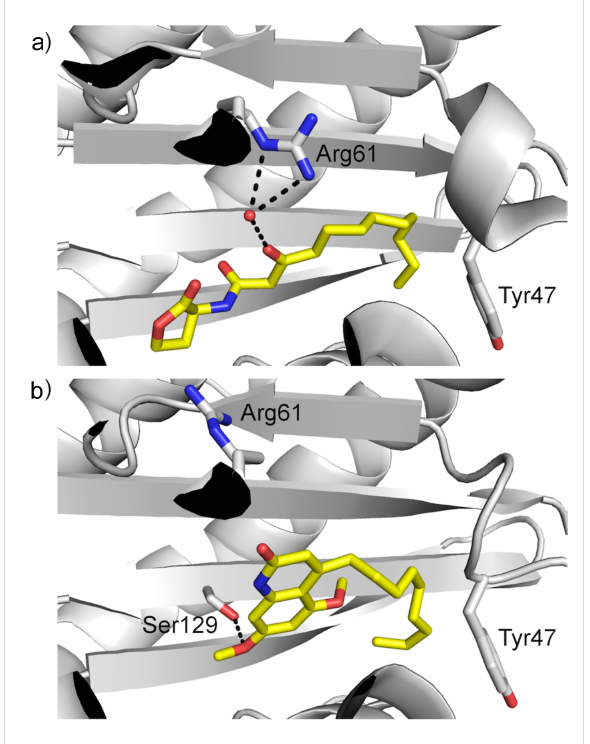
Figure 3: Binding poses of OdDHL and compound 4 in OdDHL binding site. Hydrogen bonds are shown in black dotted lines. a) Crystal struc- ture of OdDHL bound to LasR LBD (PDB 2UV0 [31]). b) Top-scoring pose of compound 4 obtained by docking into LasR